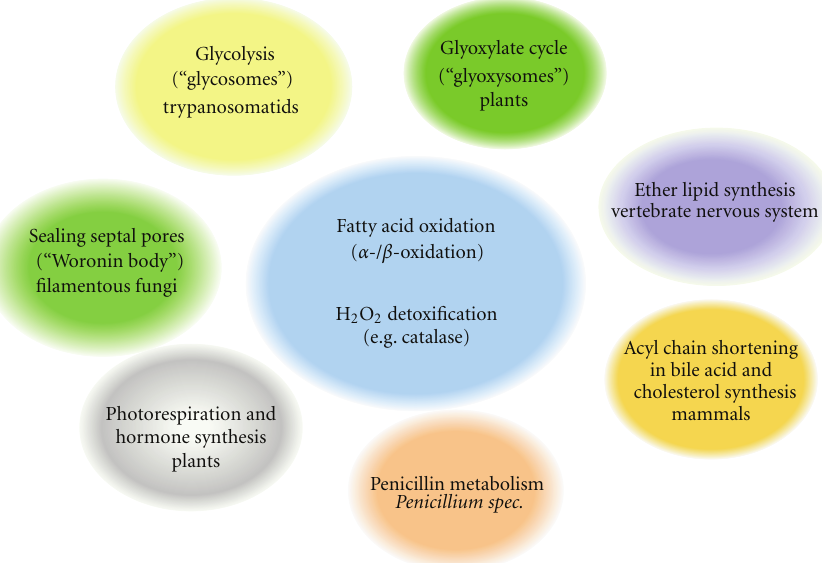
Figure 1: Overview of peroxisome functions in di ff erent organisms and tissues. Peroxisomes display a great variety in metabolic pathways as defined by their respective enzymatic content. Most eukaryotes share peroxisomal enzymes for fatty-acyl-CoA metabolism ( α - and β - oxidation) and detoxification of hydrogen peroxide by catalase. In addition, several specialized metabolic pathways housed in the peroxisomal matrix of various organisms or tissues are